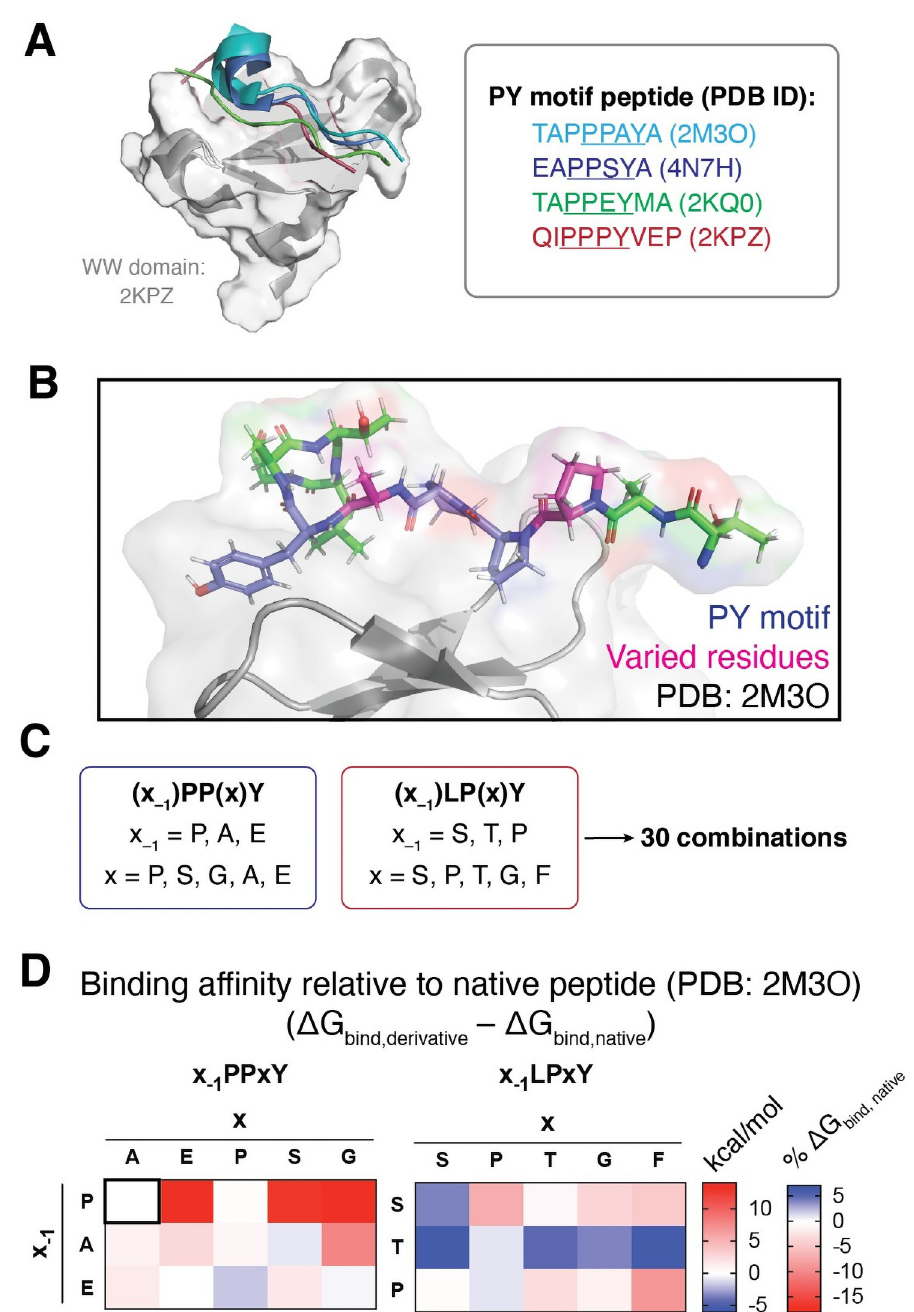
Fig 6. Rational design and computational analysis of PY motif peptide library to predict residue-specific changes in binding affinity. (A) Nedd4 WW domain (PDB ID: 2KPZ) in complex with PY motif peptides from previously resolved WW domain/PY peptide complexes (PDB IDs: 2KPZ, 2M3O, 2KQ0, 4N7H). Peptides aligned to the 2KPZ complex using PyMol [75], showing moderate conservation of peptide backbone conformation when bound to the WW domain. (B,C) Rational design of PY peptide library involved variation of residues in the x –1 and x positions (shown in pink, B ) and was informed by PY motif consensus sequences for Nedd4 (shown in Fig 2C and S2 Fig), affording a 30 member library. (D) Computationally predicted binding affinities of PY motif peptides screened against Nedd4 WW domain (PDB ID: 2M3O). Binding affinities are presented as ΔΔ G binding relative to the native peptide substrate TAPPPAYATLG ( Δ G bindingdesigned − Δ G bindingnative ). ΔΔ G binding for the native peptide is presented in the upper-right corner of the left heatmap for reference. ΔΔ G binding energies presented as kcal/mol or % of Δ G bindingnative . Full energy properties provided as in S1